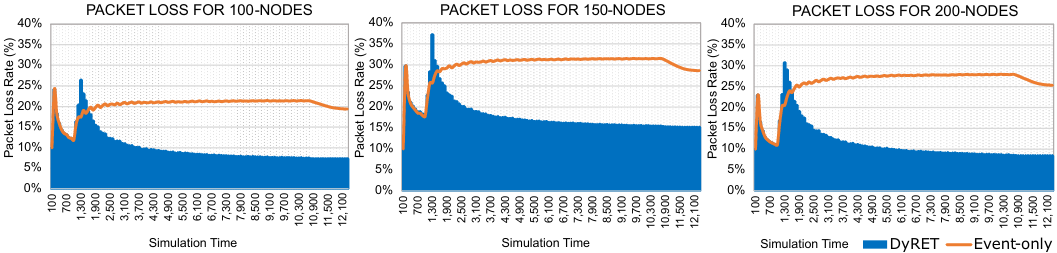
Figure 13. Timeline of packet losses (the range evaluated is 0 until the time the values remain